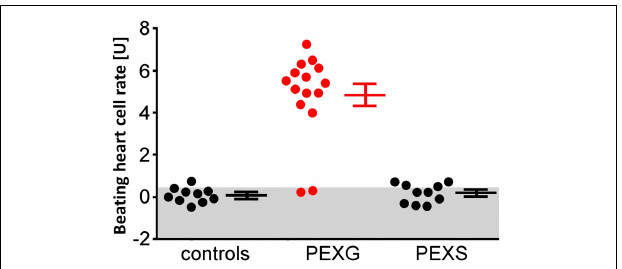
FIGURE 1 | Adrenergic activity of β 2 -AAbs in sera of patients with PEX syndrome (PEXS), PEX glaucoma (PEXG), and controls. Beating heart cell rates were shown for each group [absolute data, mean ± standard deviation (SD)]: controls, patients with PEXG and PEXS. One unit (U) reflects 4 beats/min. The values represent the adrenergic activity of β 2 -Abs. Samples less than 2 units of adrenergic activity were considered as normal. Increased beating heart cell rate was to be observed for patients with PEXG (red) when compared to patients with PEXS and controls as measured by rat cardiomyocyte beating heart cell rates.